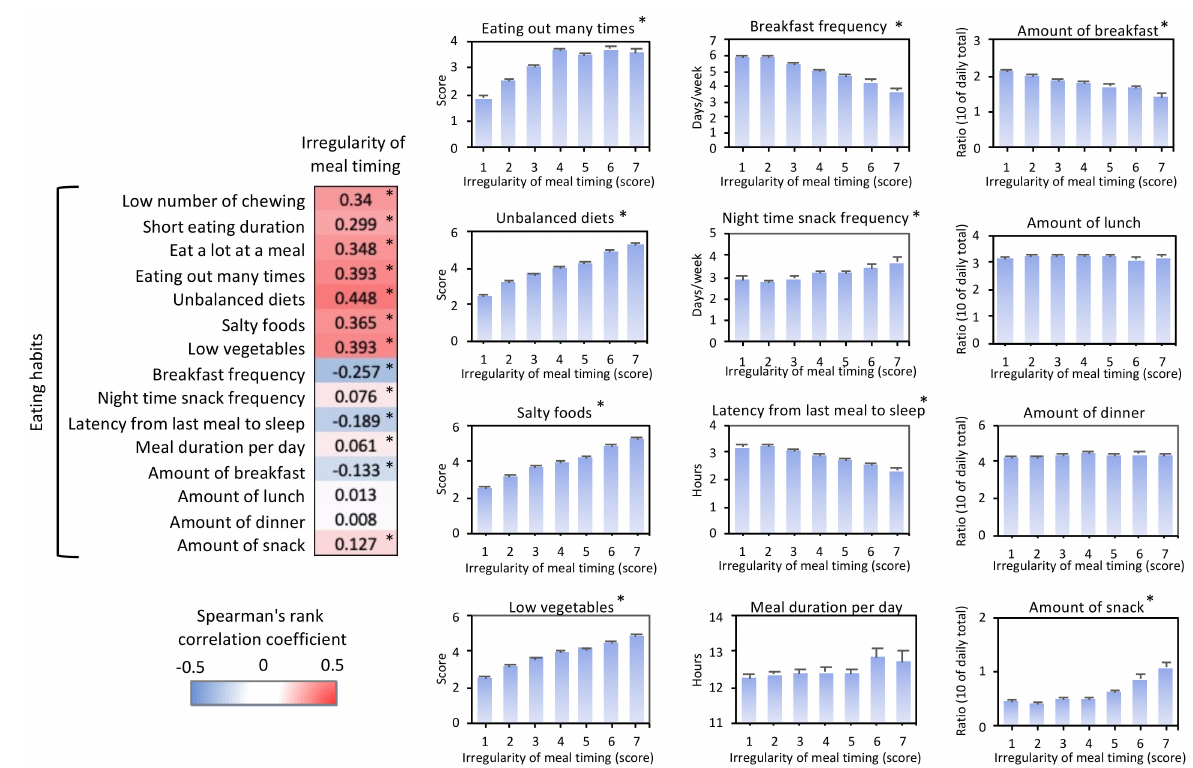
Figure 2. Irregular meal timing versus eating habits. Spearman’s correlation analysis (left panel) and averaged values (right panels) of “irregularity of meal timing” and other eating habits. Asterisks (*) in each column indicate the significance of correlation ( p < 0.001) at the correlation analysis. The seven-step answer of each questionnaire was averaged to show in the right graph. Higher “score” means the result is similar to the “strongly agree” response for the questionnaire, as described in the methods section. Asterisks (*) on the upper right side in each graph also indicate the significance by the Kruskal–Wallis test ( p <